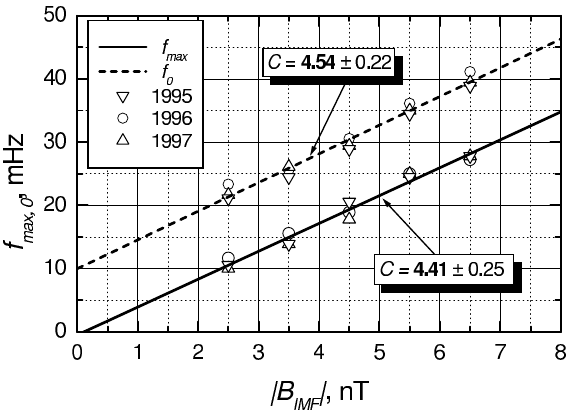
Fig. 8. Experimental dependence of spectral maximum frequency (circles and triangles) on IMF magnitude at Davis over 1995–1997 and corresponding linear fit lines. The solid line represents an esti- mate for the band-limited signal (f max ) , and the dashed line corre- sponds to that for the signal -to- noise ratio (f 0 ) .